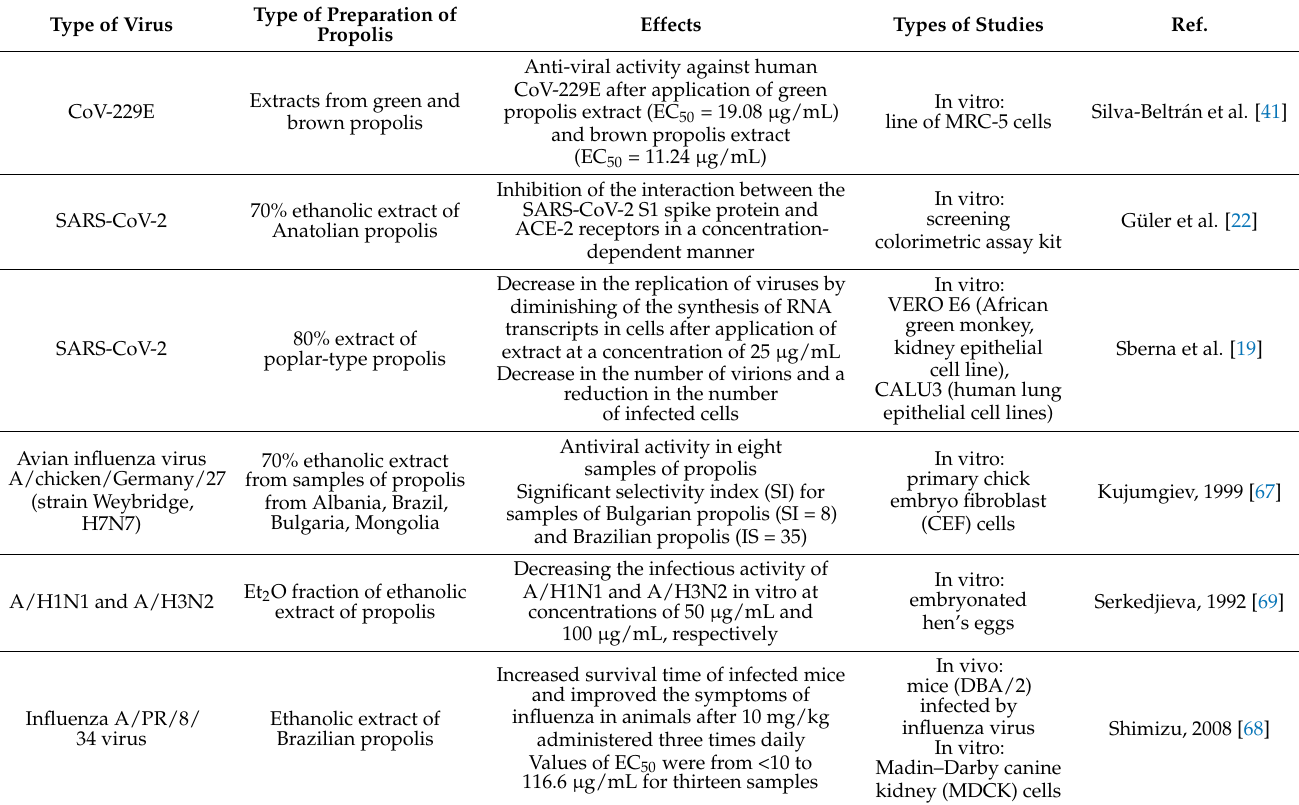
Table 1. Summary of the antiviral activity of propolis against respiratory viruses obtained in n preclinical